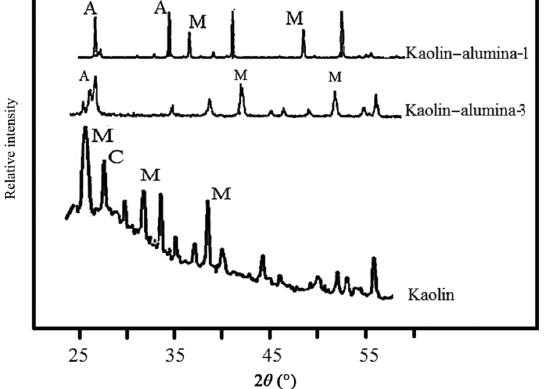
Fig. 7 XRD results of kaolin–alumina and kaolin hollow fibres sintered at 1450 ℃ . M: mullite, A: alumina, C: